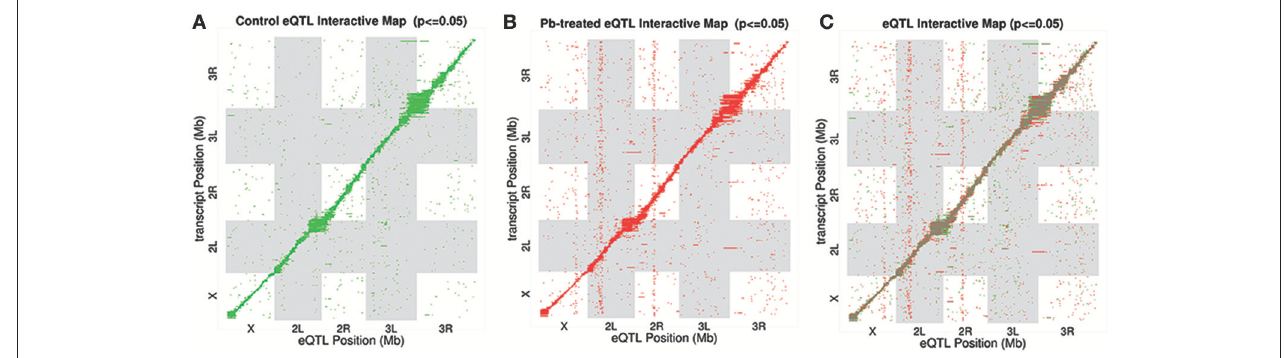
FIGURE 1 | eQTL Map. All significant associations were shown in an eQTL map with eQTL locations (genomic loci) on x-axis and transcript locations (gene loci) on y-axis. (A) Associations for control samples only. Each of the green dots indicates a significant association between the corresponding eQTL location and the gene at the transcript location. (B) eQTL Interactive Map for lead-treated samples only. Each of the red dots indicates a significant signal. (C) eQTL Interactive Map combining both control and lead-treated samples. Shared significant signals were marked as brown, with lead-specific signals as red and control-specific ones as green.